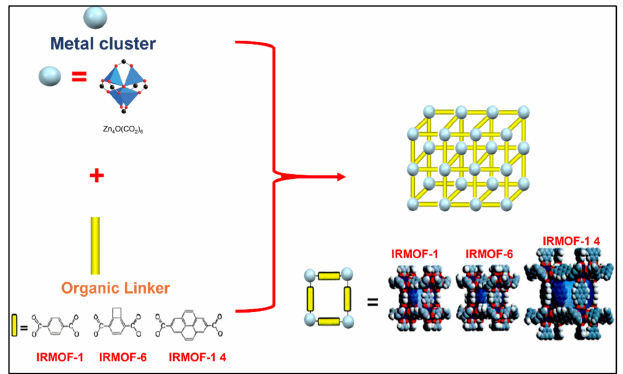
Figure 9. Metal-organic frameworks structures.